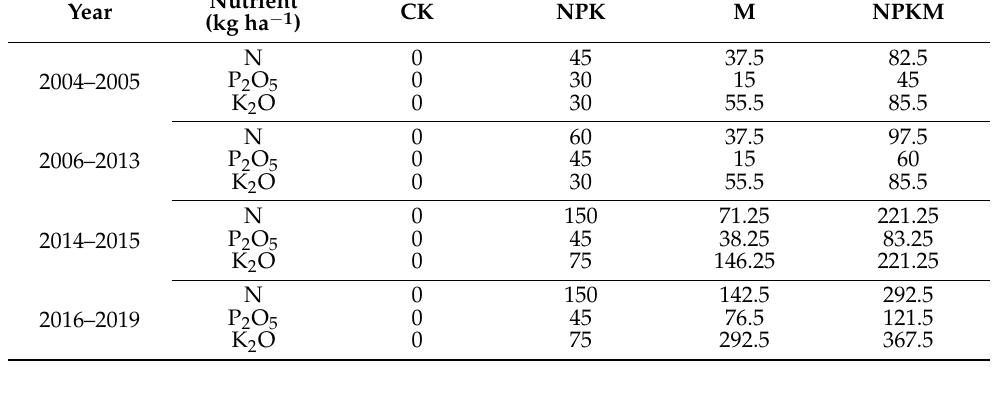
Table A1. The amount of fertilizer applied under different treatments (kg ha − 1 ).